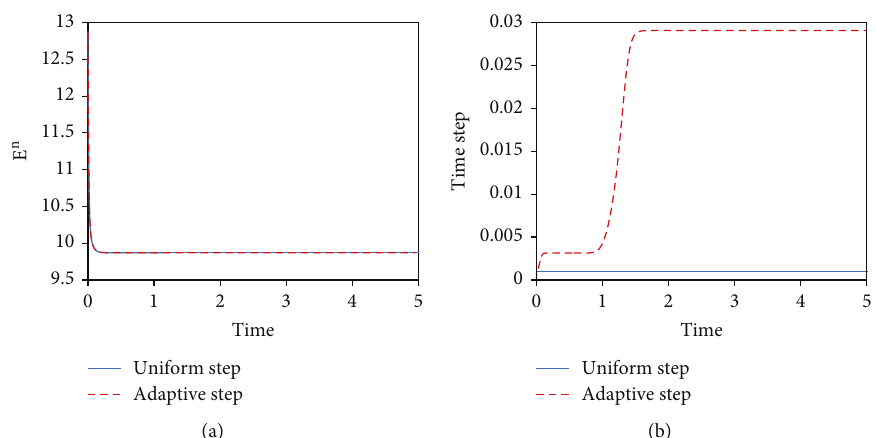
Figure 2: Evolutions of energy (a) and comparison of time steps (b) of the stabilized BDF2 scheme (6) for the EFK equation using di ff erent time strategies until time T = 5